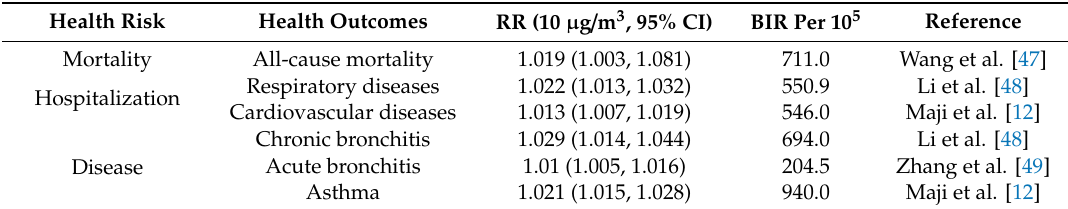
Table 1. PM 2.5 pollution relative risk (RR) factor and baseline incidence rate